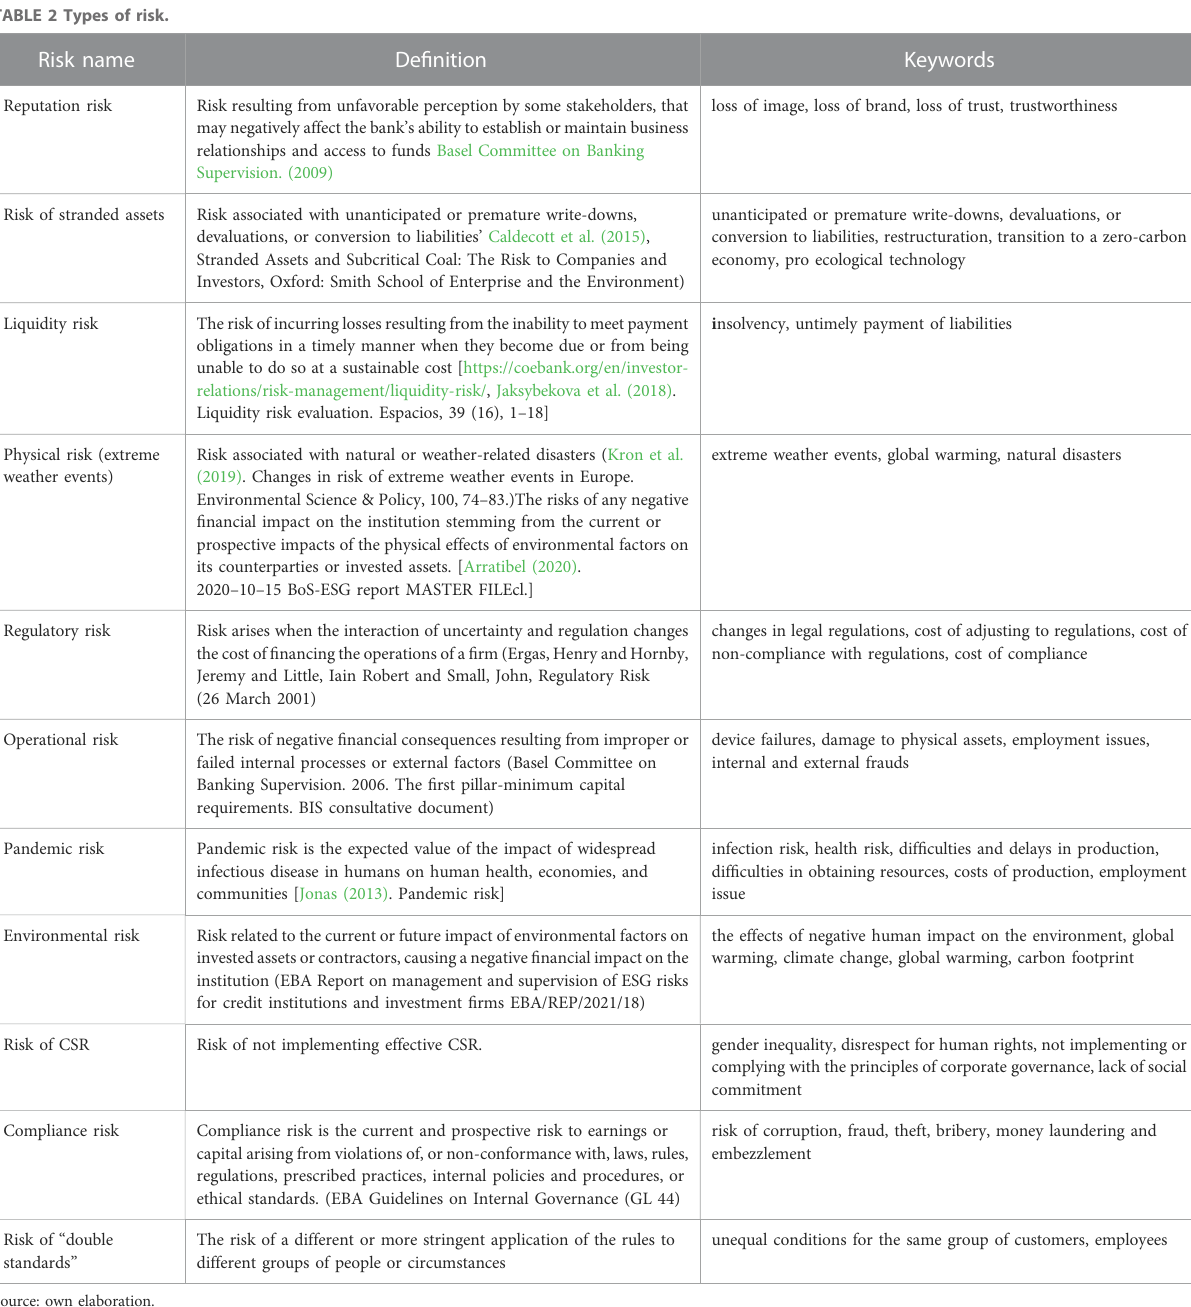
Figure 9 presents the relationship between ESG risk — bank based model and ESG risk - market based model. The fi gure shows how the ESG risk affects the bank and market-based models and the company that must adapt to the changes caused by the ESG risk. The bank may stop servicing the enterprise and may also permanently limit access to its services and